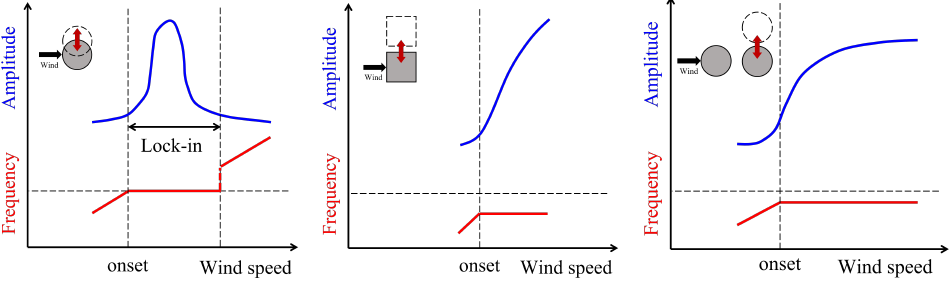
Figure 1. Comparison of amplitude-velocity and frequency-velocity of FIV phenomenon: VIV ( left ); instability like galloping and flutter ( middle ); and, wake galloping ( right